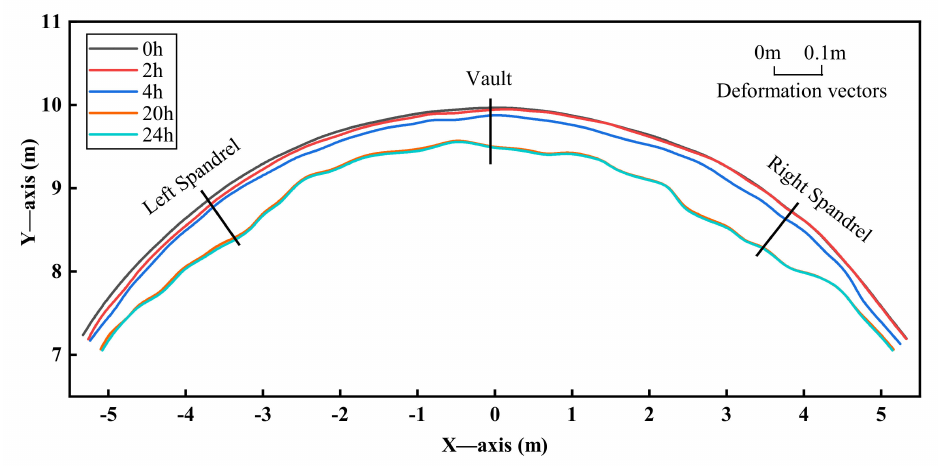
Figure 12. Evolution diagram of the initial support deformation of the upper step of the tunnel